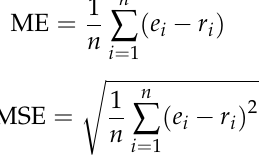
Figure 6. Water saturation in the field.